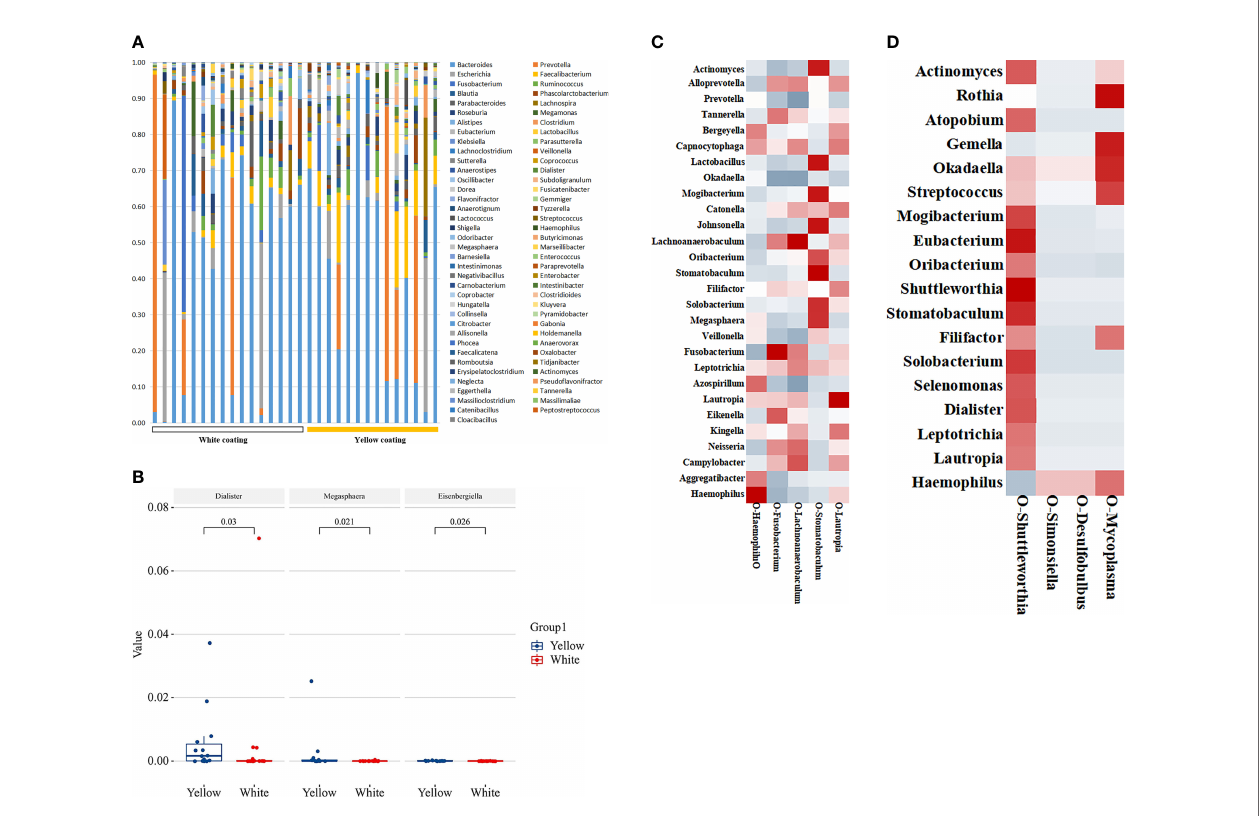
FIGURE 5 | Distribution of intestinal fl ora. (A) The distribution of different groups at the genus level is shown in the bar chart. (B) Bacterial communities with statistical differences between the two groups are shown in the boxplot. In (C, D) , the correlation between tongue coating bacteria and intestinal bacteria in the White Coating Group and Yellow Coating Group, respectively, are shown in the